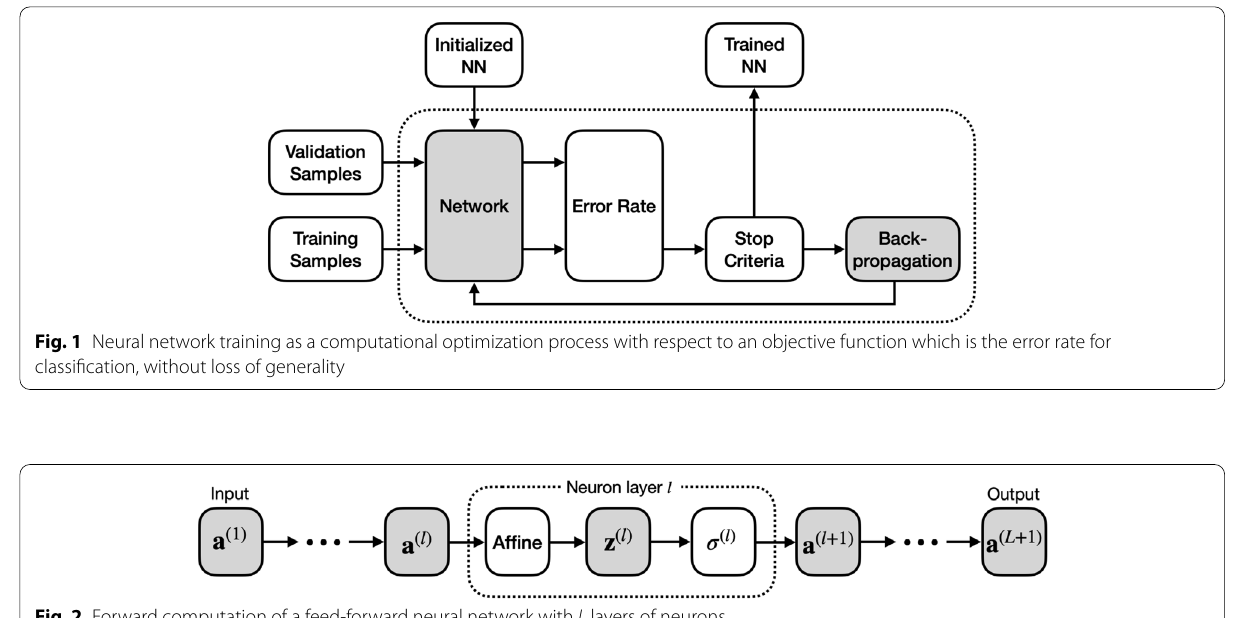
Fig. 2 Forward computation of a feed-forward neural network with L layers of